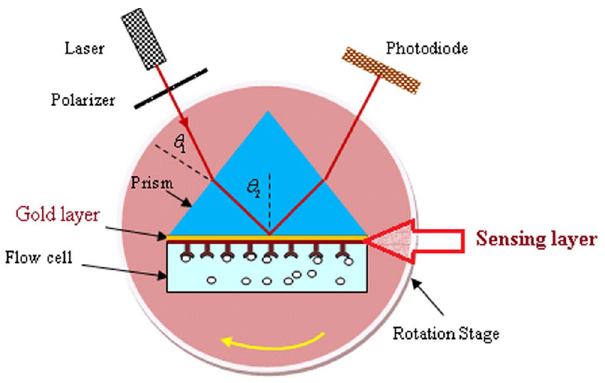
Figure 1. The SPR setup contains a He-Ne laser, a polarizer, a photodiode, a flow cell, a rotation stage, and a high refractive